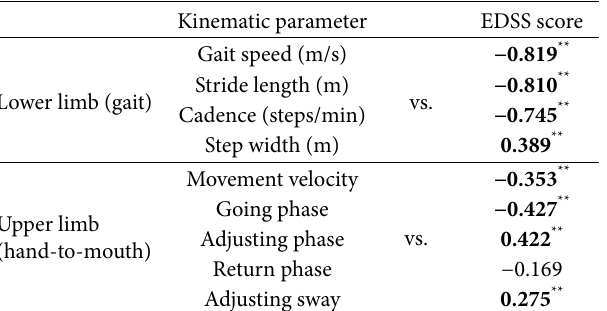
Table 4: Spearman’s rho coefficients of correlation between EDSS score and upper and lower limb kinematic parameters in people with multiple